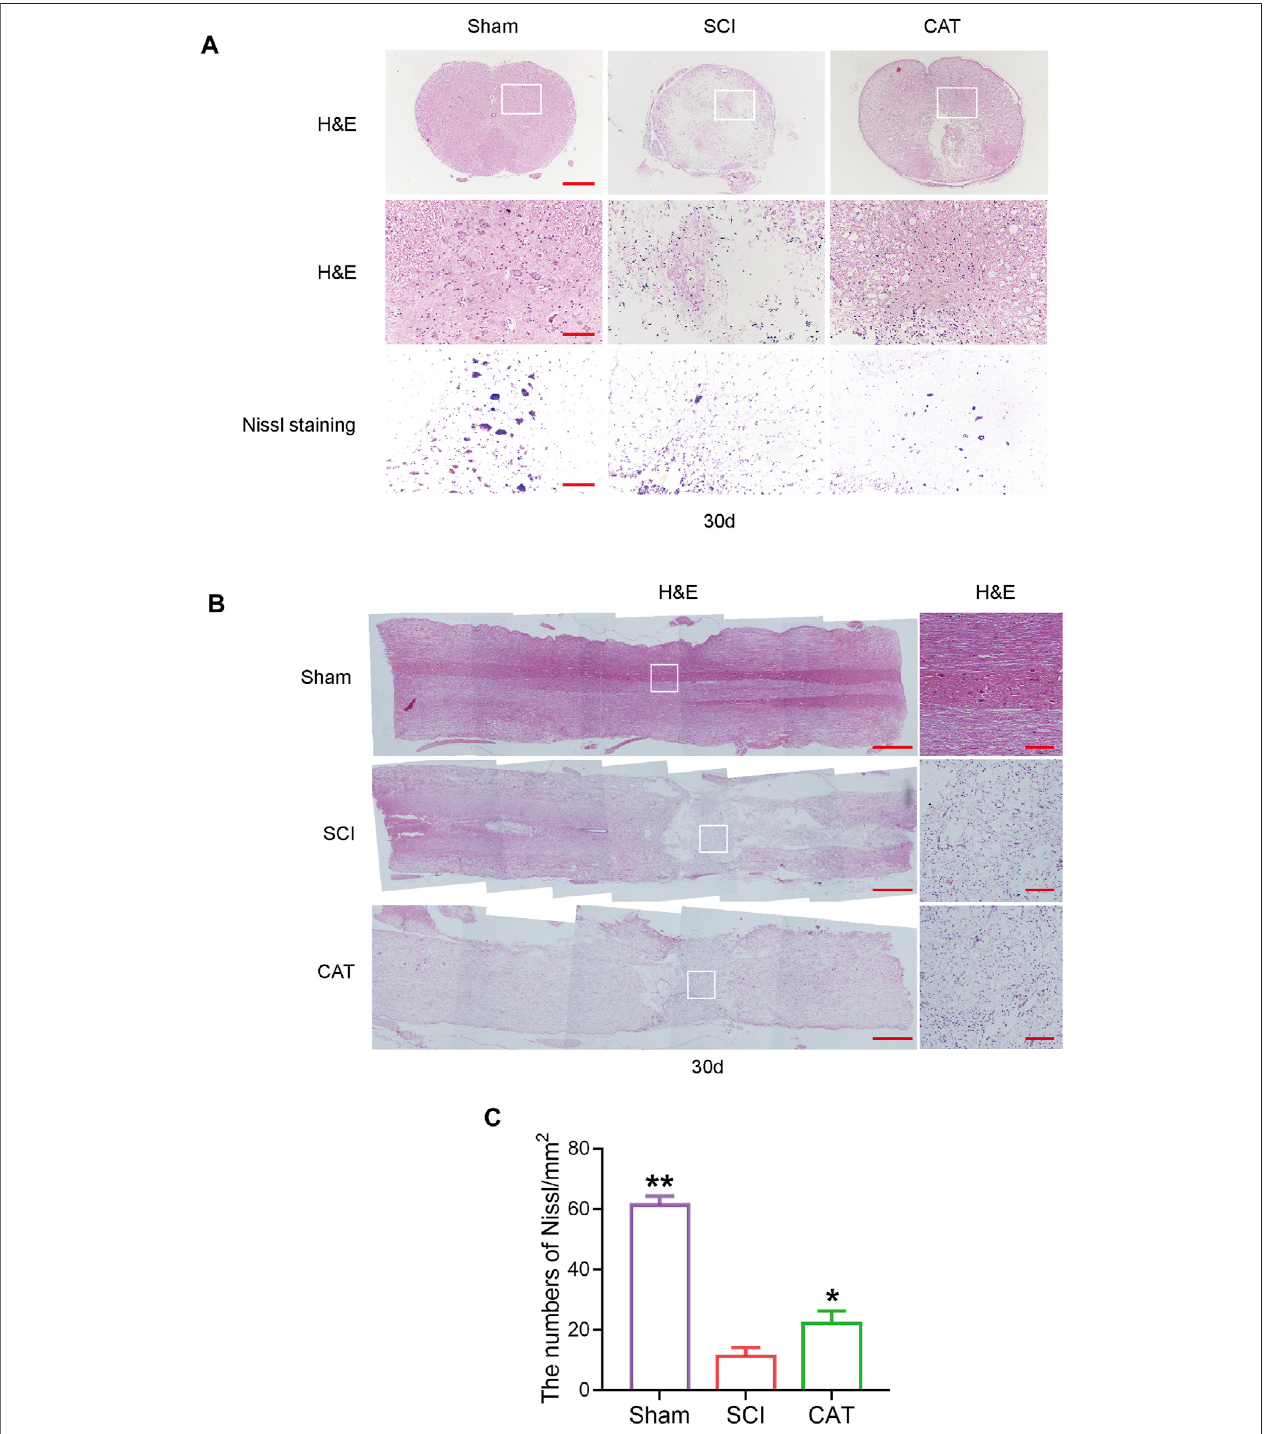
FIGURE 3 | CAT improves the recovery of SCI rats. (A) H&E staining was performed on crosssection slides of spinal cords from the Sham group, the SCI group, and theCAT group, scalebar = 500 μ m.Boxed areas arehigh-power image areas withscalebar = 100 μ m. NisslstainingofsamplesfromtheSham group, SCIgroup, and CAT group,scalebar = 100 μ m. (B) Longitudinalsectionsofspinalcords fromtheShamgroup, theSCIgroup, andtheCAT groupweresubjectedtoH&Estaining, scale bar = 500 μ m. Boxed areas are high-power image areas, scale bar = 100 μ m. (C) Analysis of the Nissl staining results. Student ’ s t test was used to analyze Nissl staining results. “ * ” represents p < 0.05, “ ** ” represents p < 0.01 versus the SCI group with statistical signi fi cance. Data are represented as mean ± SD ( n = 3).